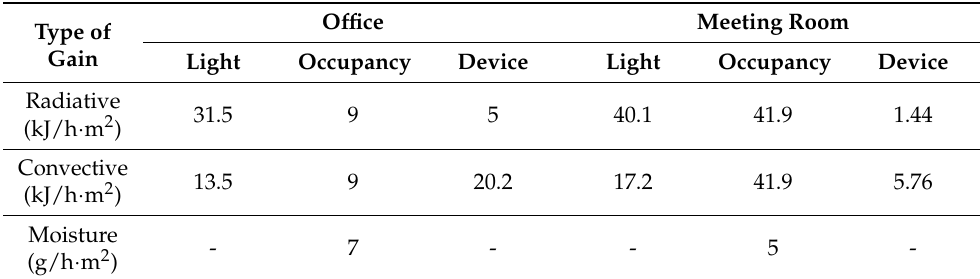
Figure 4. ( a ) transient system simulation tool (TRNSYS) model of the CCHP system of Figure 1, including a CHP system and an HDCS, ( b ) a three-dimensional (3D) office building model prepared with SketchUp, and ( c ) a model of conditioned spaces for TRNBuild. Table 3. Indoor heat and moisture gains